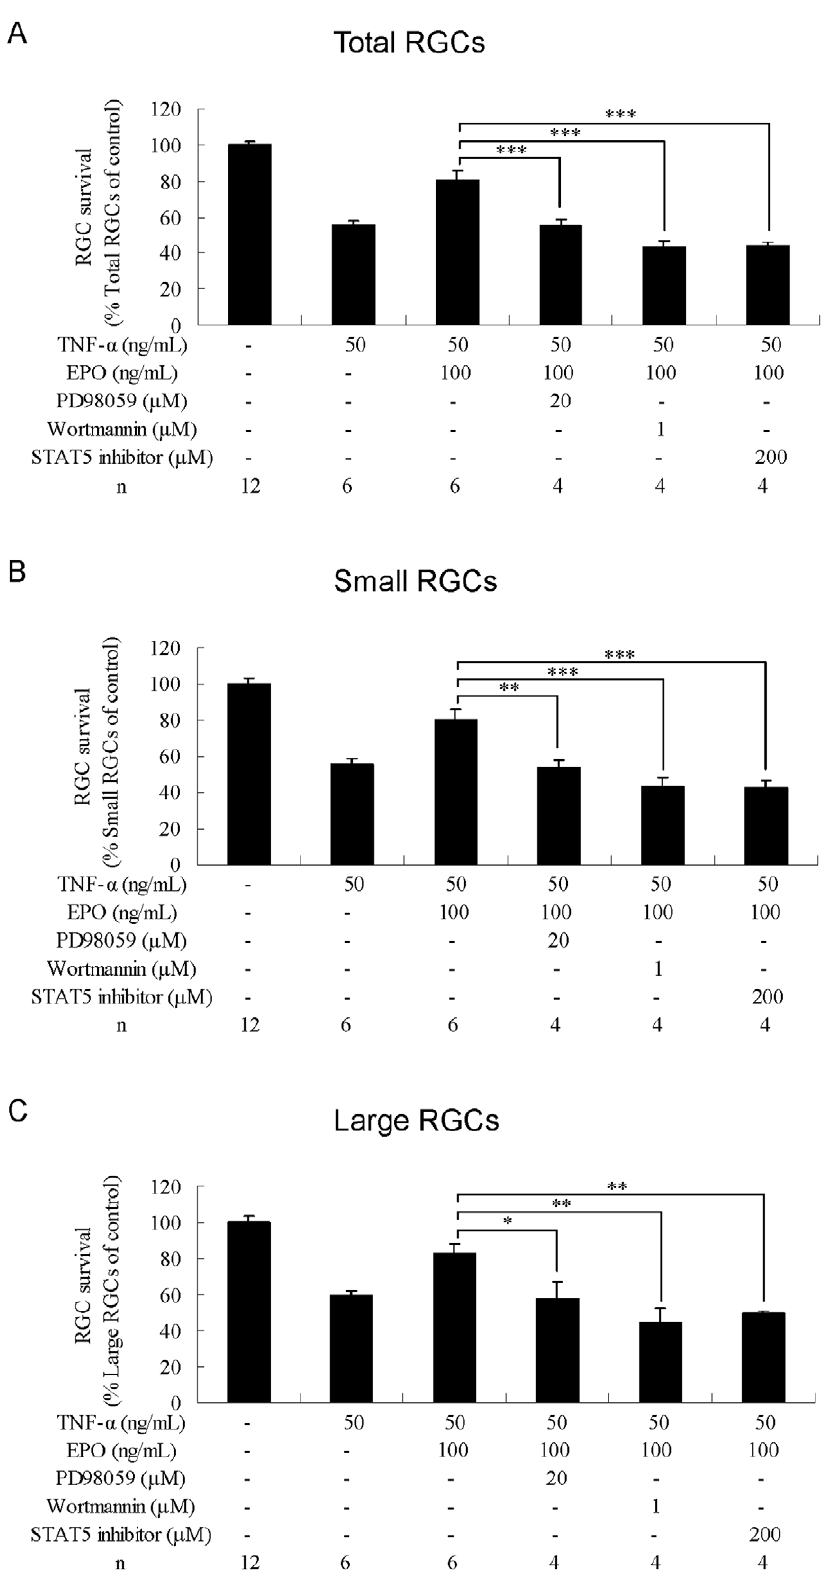
Figure 7. Effects of combined treatment with erythropoietin and kinase inhibitors on RGCs under TNF- a -induced toxicity. Survival rates of (A) total, (B) small, and (C) large RGCs were estimated as percentages of the control. Data are presented as mean 6 standard error of the mean (n=6–12). Data were statistically analyzed by 1-way ANOVA, followed by the Dunnett’s test. *P , 0.05, **P , 0.01 and ***P , 0.001.